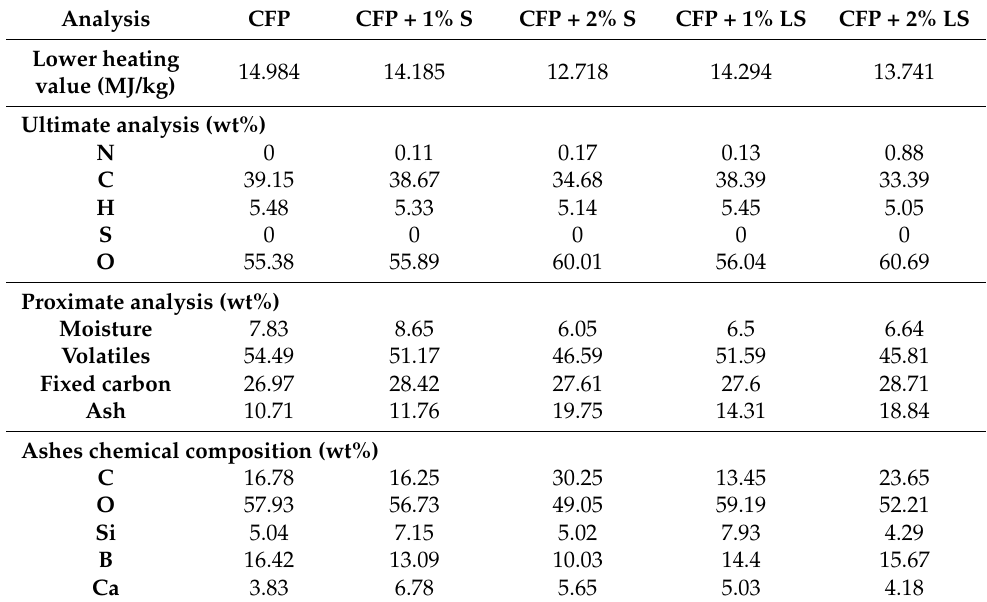
Table 3. Combustion characterization of the CF combinations and the ashes’ chemical compositions.